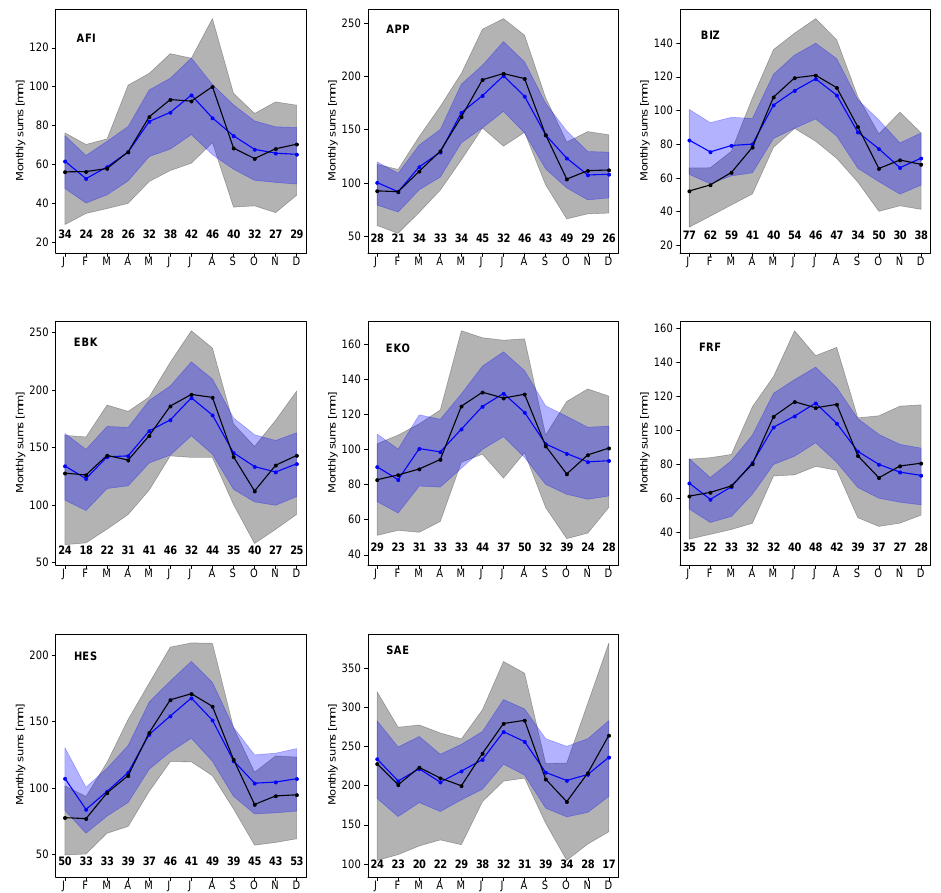
Figure 3. Long-term mean and variability of monthly precipitation sums during the period 1961–2011 for eight stations in the Thur catch- ment. The black (blue) lines refer to the mean annual cycle of observed (modelled) precipitation sums. The grey (blue) shaded areas repre- sent the inter-quartile ranges of observed (simulated) monthly precipitation sums. The simulation comprises 100 realisations covering every 51 years. The numbers at the bottom indicate for each month the percentage of variance explained by the precipitation generator. Note that the scale of the y-axis differs between different